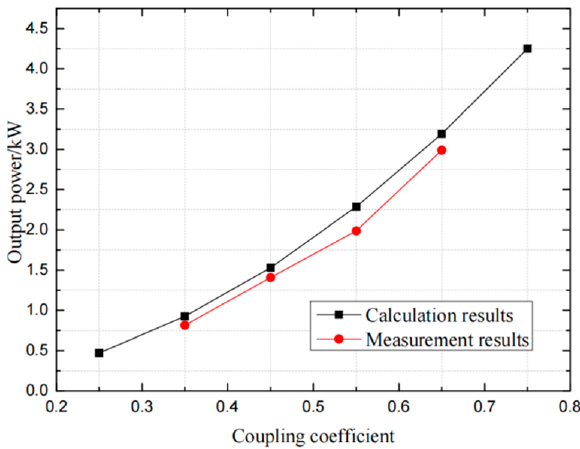
Figure 26. Comparison of transmission power. As shown in Figure 27, in the actual test, when the load changes within a certain range, the output current is basically constant and is about 44 A. The measured value and the calculated value have the same trend, but the measured value is slightly lower than the calculated value. This may be due to the presence of resistance in the actual circuit.